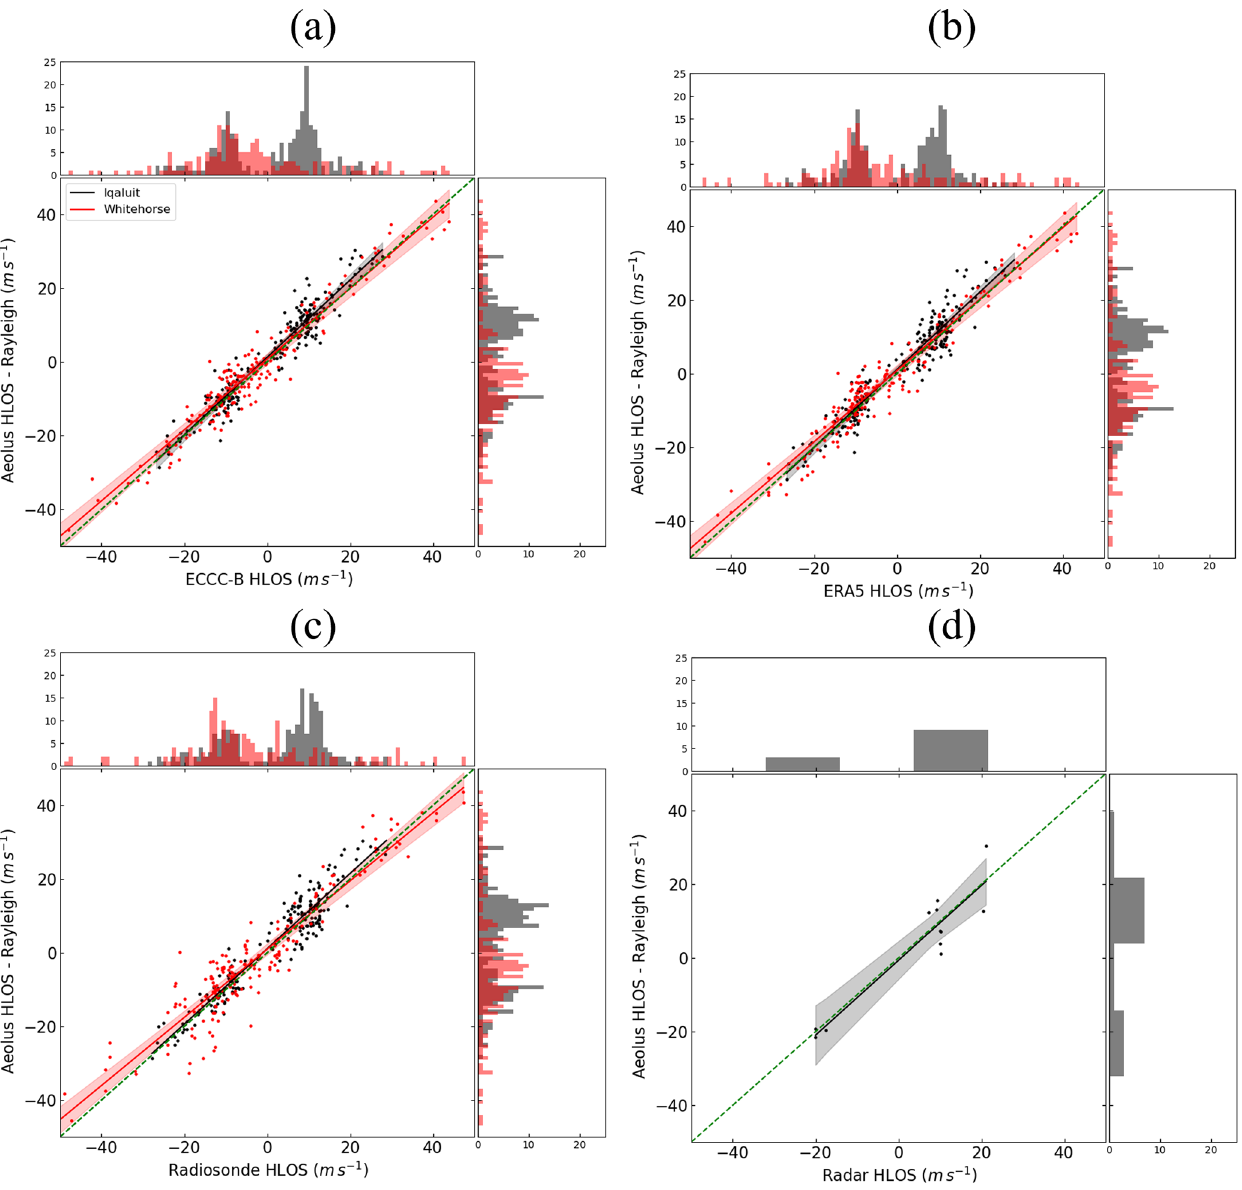
Figure 4. Scatter plots between Aeolus Rayleigh winds and (a) ECCC-B, (b) ERA5, (c) radiosondes, and (d) Ka-band radar and frequency distributions in percentage around the Iqaluit and Whitehorse supersites during the early FM-A